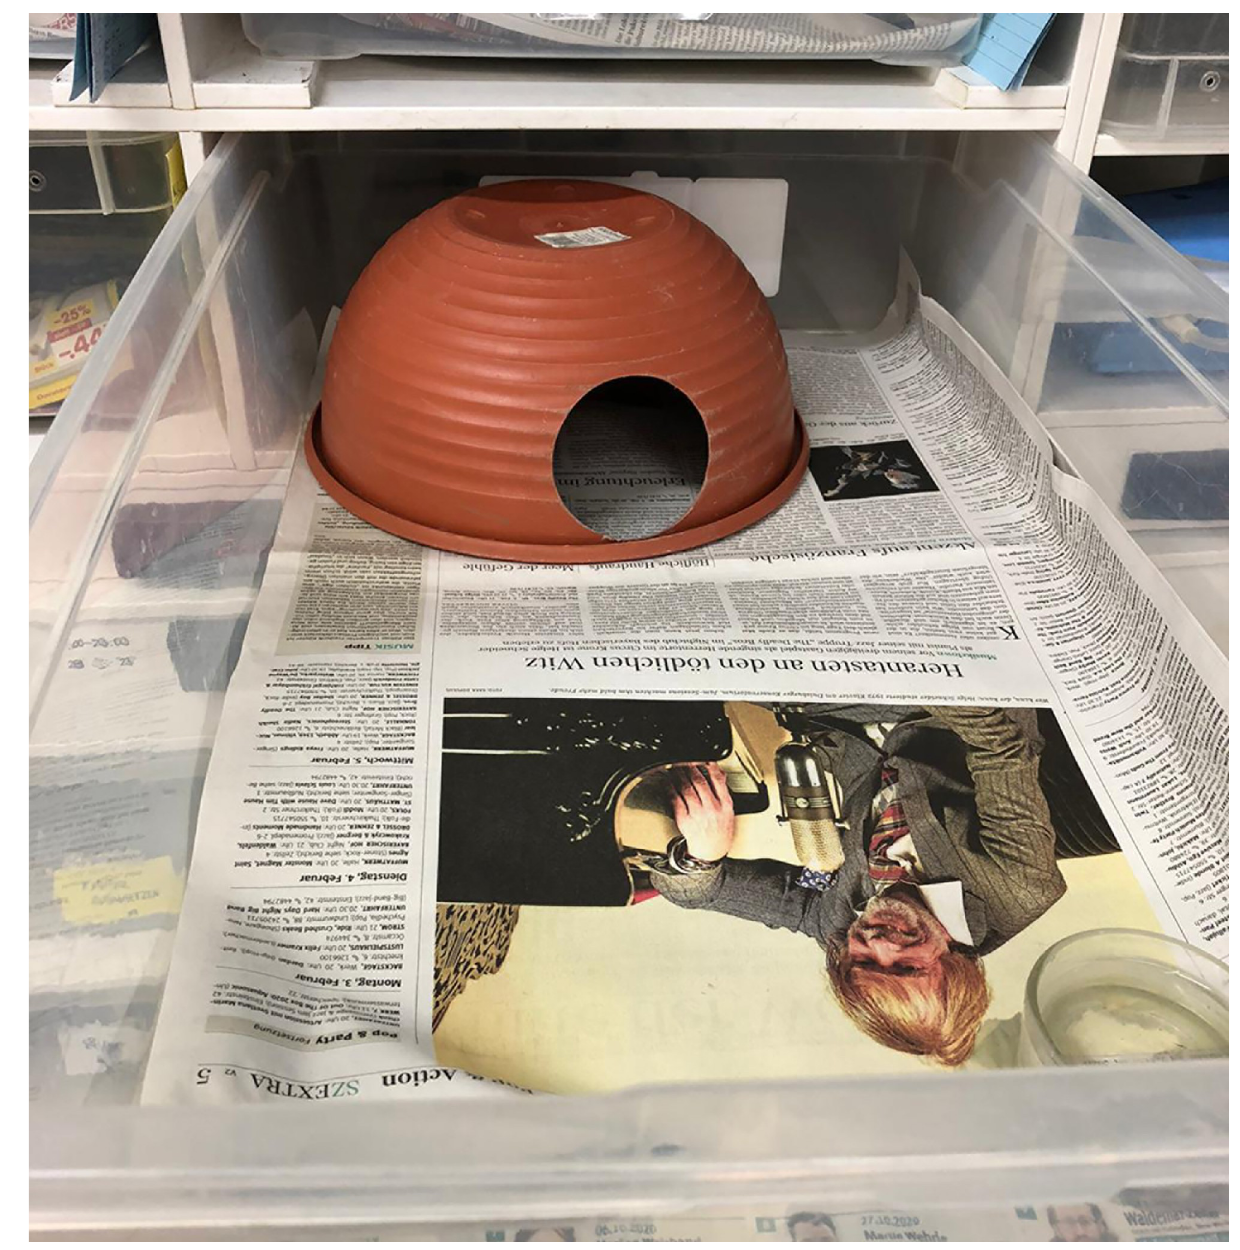
Fig 2. Photo of a rack